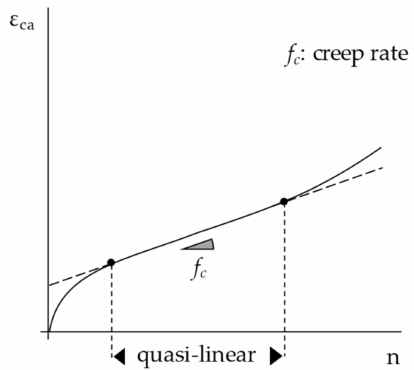
Figure 2. The creep rate parameter determined through the CCT test.